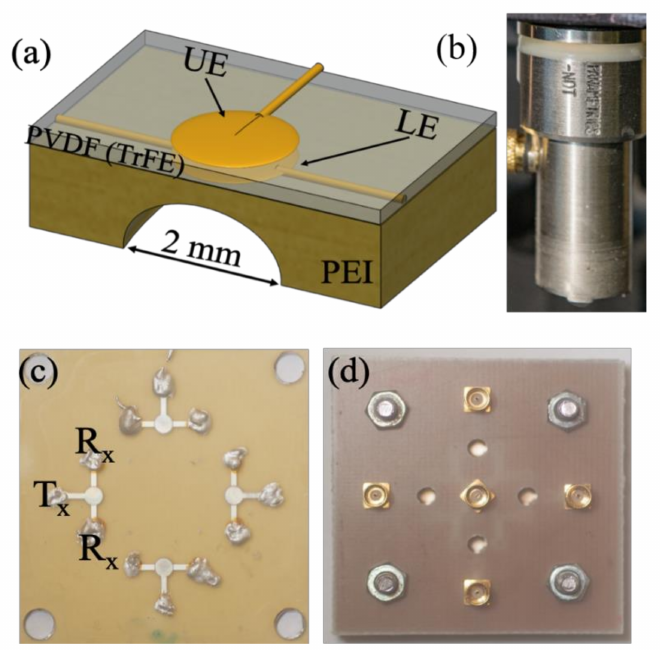
Figure 2. ( a ) Schematic representation of the fabricated in-house P(VDF-TrFE) copolymer transducer, and ( b ) image of the commercial Olympus PVDF transducer, both with center frequencies around 40 MHz ( c ) Optical image of a transducer panel containing four transducers, and ( d ) connection RF plugs for the transducers mounted on a printed circuit board for further cable connection to the signal generator and receiver.